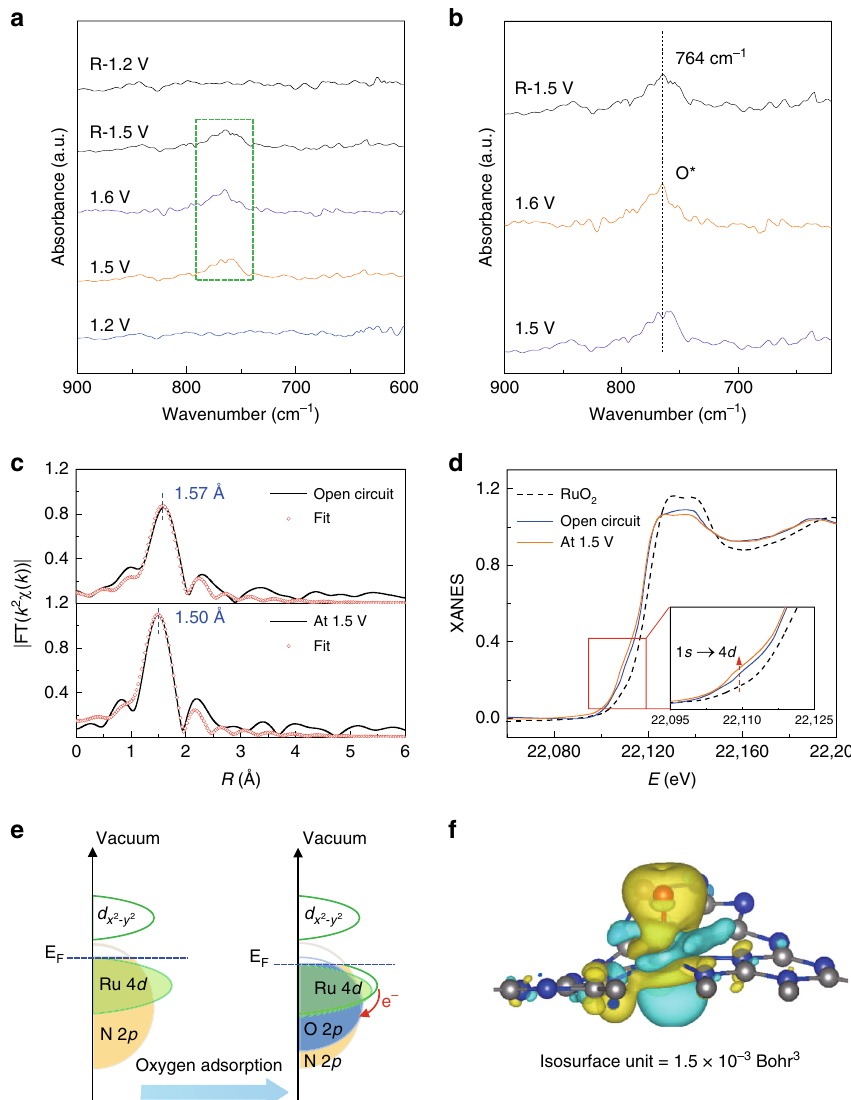
Fig. 3 Operando SR-FTIR spectroscopy and XAFS measurements. a Operando SR-FTIR spectroscopy measurements for Ru-N-C during the acid OER. b The enlarged infrared signal at ~764 cm − 1 . All potentials are normalized referred RHE. c Operando EXAFS spectra and fi rst-shell fi tting curves for Ru-N-C at different applied voltages from the open circuit condition to 1.5 V during OER. d Operando XANES spectra for Ru-N-C during OER. Inset: magni fi ed pre- edge XANES region. e Schematic illustration of the effect of oxygen adsorption on the electronic structure of Ru-N-C. f Electron density difference plot of the O-Ru 1 -N 4 . Yellow and light green contours represent the electron accumulation and deletion, respectively. The balls in gray, blue, red, white, and light green represent C, N, O, H, and Ru atoms, respectively. All potentials are normalized to